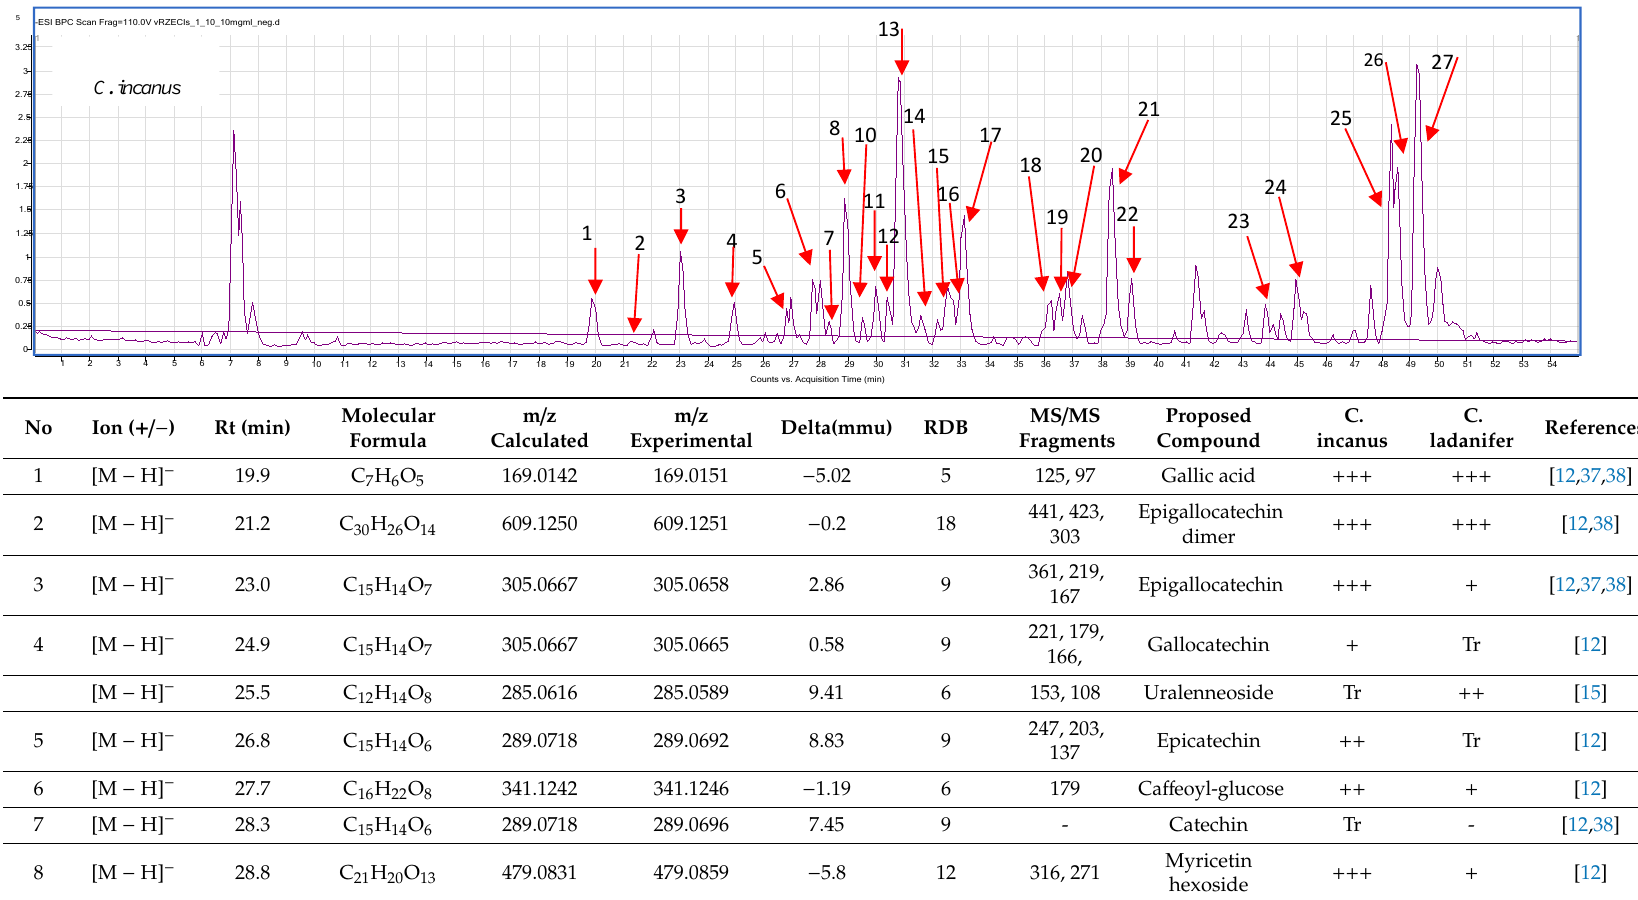
Table 3. Results of the qualitative LC-MS study of C. incanus and C. ladanifer extracts (delta—the calculated molecular weight error, DBE—double bond equivalent, deriv—derivative, Tr—traces).